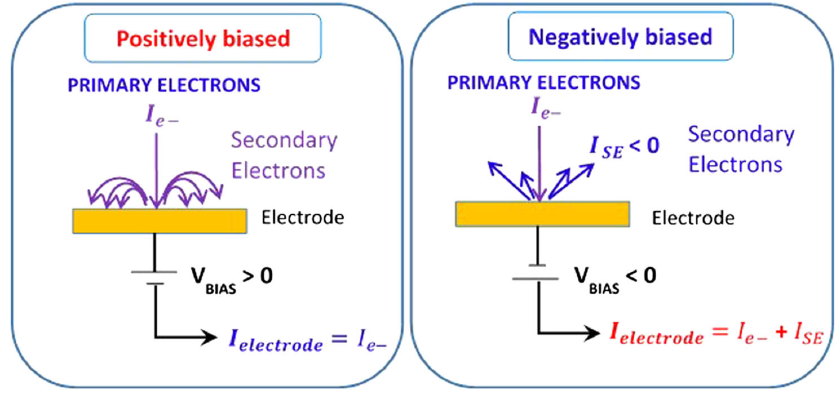
FIG. 1. Basic schematic of the electron current measurement with a positive (left) and a negative bias (right)